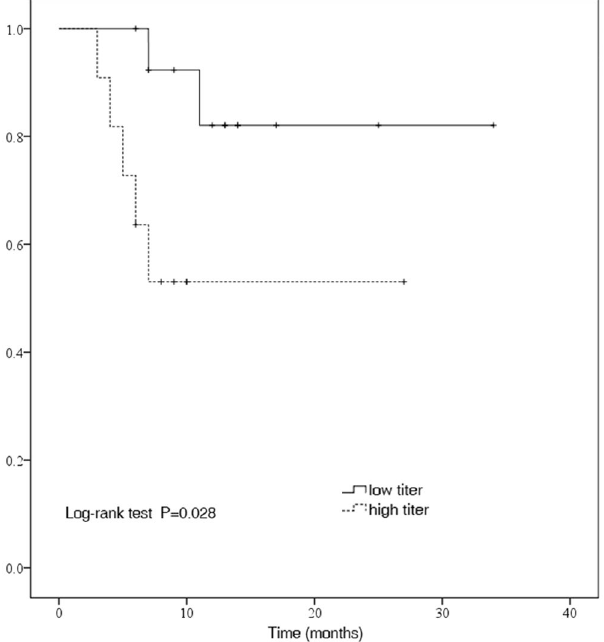
Figure 2. Kaplan–Meier estimates probability of being free of any relapse by AQP4-IgG serostatus after tacrolimus treatment. Kaplan–Meier analysis revealed that there was a significant difference between the high titer ( ≥ 1:64) group of aquaporin 4 antibody (AQP4-IgG) in the serum and the low titer group( < 1:64 or none) regarding relapses while undergoing tacrolimus therapy (P = 0.028 by log-rank test).